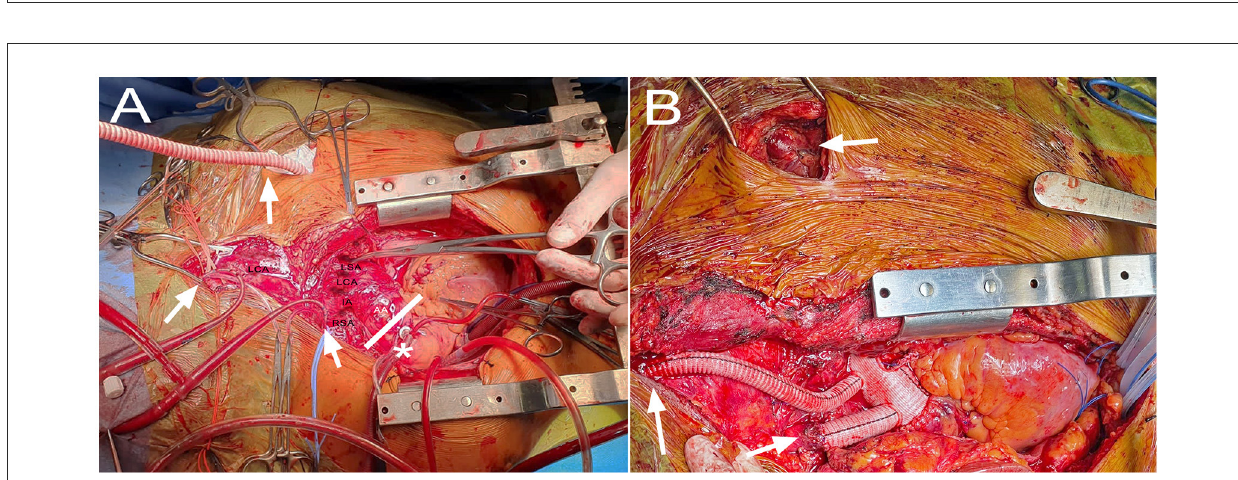
FIGURE2 Intraoperative images showing (A) perfusion setup with direct ascending aorta (AA) cannulation in the uncompromised segment (*), pediatric cannulas to the right subclavian (RSA) and left internal carotid arteries, and Dacron graft to the left subclavian artery (arrows). The white lines depict the cross-clamp site to allow for cardiac perfusion through the aortic cannula. The innominate artery (IA), left carotid artery (LCA) and left subclavian artery (LSA) are also appreciated. (B) The final result with the Thoraflex deployed, and its branches anastomosed to the right subclavian artery, left carotid bifurcation, and left subclavian artery